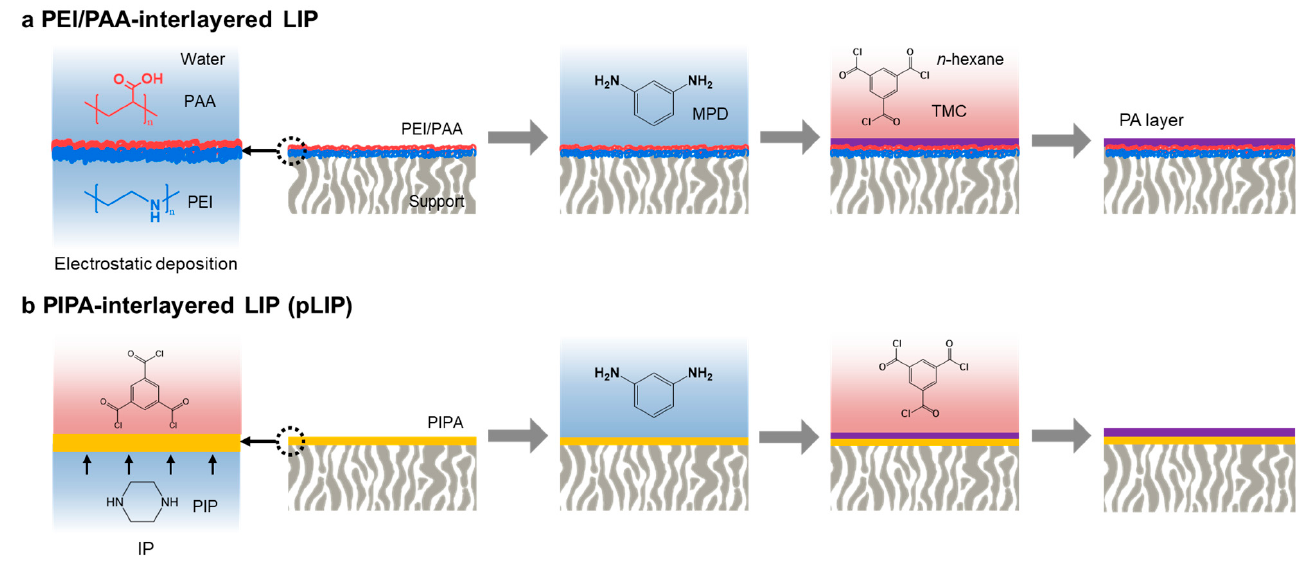
Figure 1. Schematic illustration of the membrane fabrication process. ( a ) Polyelectrolyte (PEI/PAA)- interlayered LIP and ( b ) poly(piperazineamide) (PIPA)-interlayered LIP (pLIP)